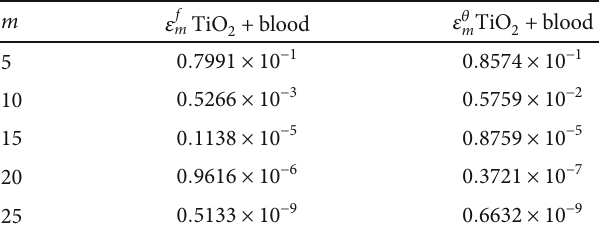
Table 4: Convergence control parameter for particular method.